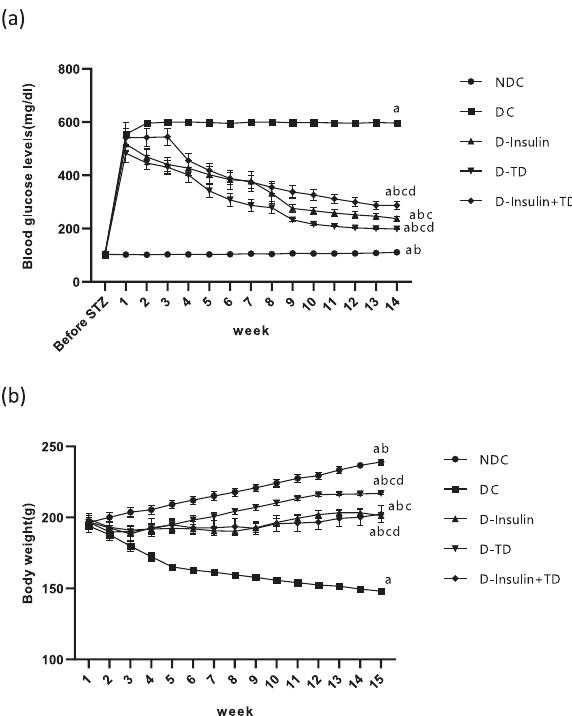
Fig. 1 Effect of TD on blood glucose levels and body weight in male rats. Comparison of fed blood glucose levels ( a ) and body weight ( b ) in the non-diabetic control (NDC), diabetic control (DC), D-insulin, D-TD, and D-insulin + TD groups. DC group received 60 mg/kg STZ. D-insulin group diabetic animals were treated with 2.5 U/kg insulin twice per day (1/3 morning and 2/3 in the evening), D-TD group diabetic animals were treated with daily IP injection of 40 mg/kg thiamine disul fi de, D-insulin + TD group diabetic animals treated with TD and insulin (2.5 U/kg insulin + 40 mg/kg TD once per day). Data are expressed as mean ± S.E.M ( N = 7). a Signi fi cant difference in blood glucose and body weight. between the DC group and other groups (DC vs NDC ( p < 0.0001), DC vs D-insulin and D-insulin + TD ( p < 0.01), DC vs D-TD ( p < 0.001). b Signi fi cant difference in blood glucose levels and body weight between NDC group and other groups (NDC vs D-TD ( p < 0.01), NDC vs D-insulin + TD ( p < 0.001). c Signi fi cant difference between D-insulin group and the other two treatment groups (D-TD and D-insulin + TD), ( p < 0.01) for blood glucose levels and ( p < 0.001) for body weight. d Signi fi cant difference in blood glucose levels and body weight between D-TD and D-insulin + TD groups ( p < 0.001). body weight (D-TD: 216.88 ± .78 g, D-insulin: 201.2 ± 2.07 g, D-insulin + TD: 202.33 ± 6.14 g). Effect of TD on glucagon tolerance test (GTT) In the last month of treatment, a glucagon tolerance test was 14123.75 ± 297.29 mg.min/ml DC: 59306.25 ± 2353.24 mg.min/ml